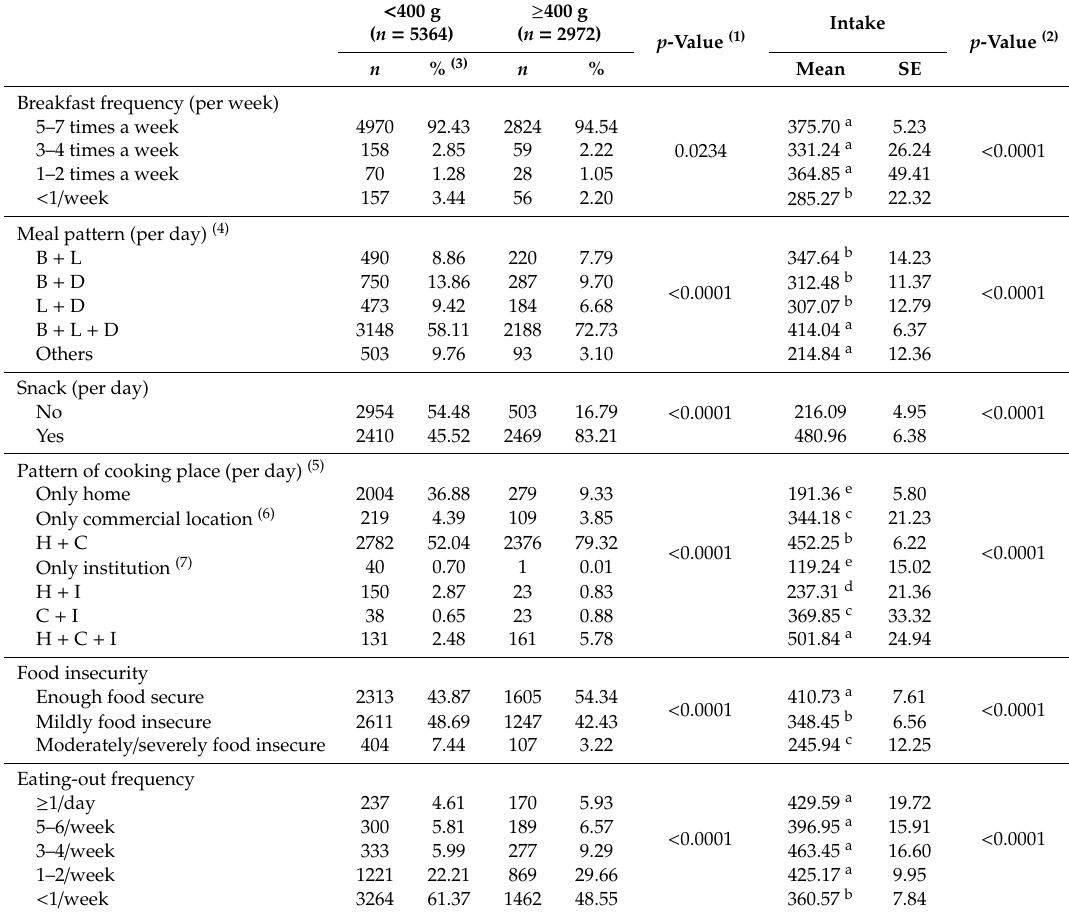
Table 3. Dietary behavior according to grouping of recommended fruits and vegetables